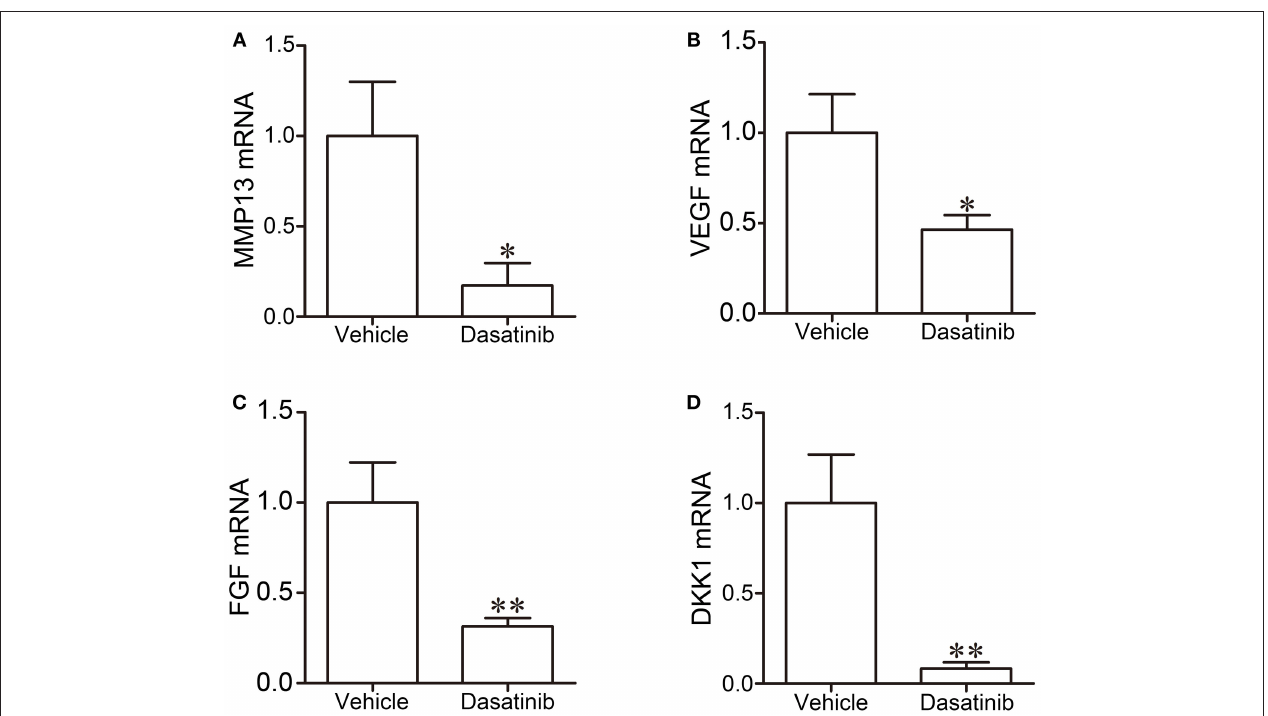
FIGURE 8 | The mRNA expression of MMP13 (A) , VEGF (B) , FGF (C) , and DKK1 (D) in FLS was measured using RT-PCR. * P < 0.05, ** P < 0.01 vs. vehicle group ( n = 3 per